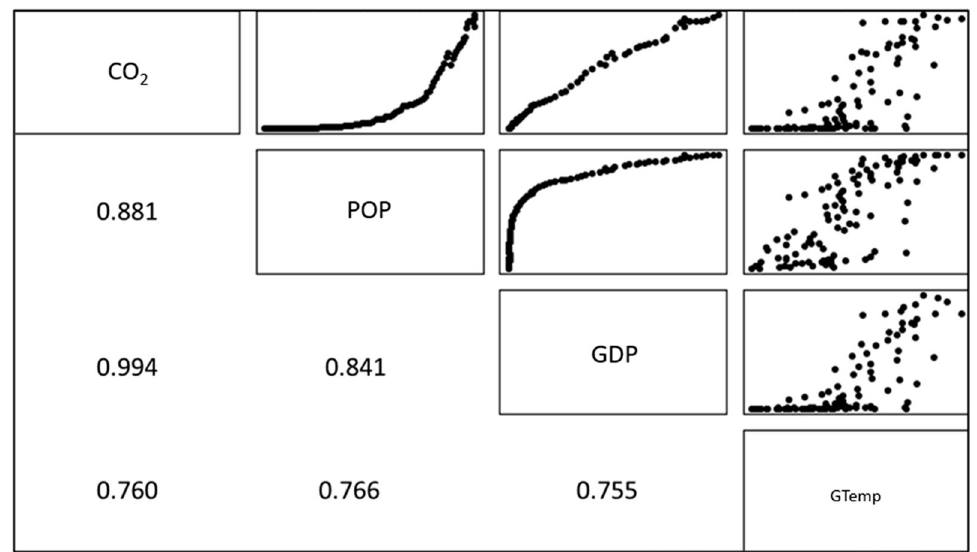
Fig. 3 Correlation plot with coefficients between CO 2 emissions, population (Pop), and GDP of South Korea and global surface temperature anomalies (GTemp)